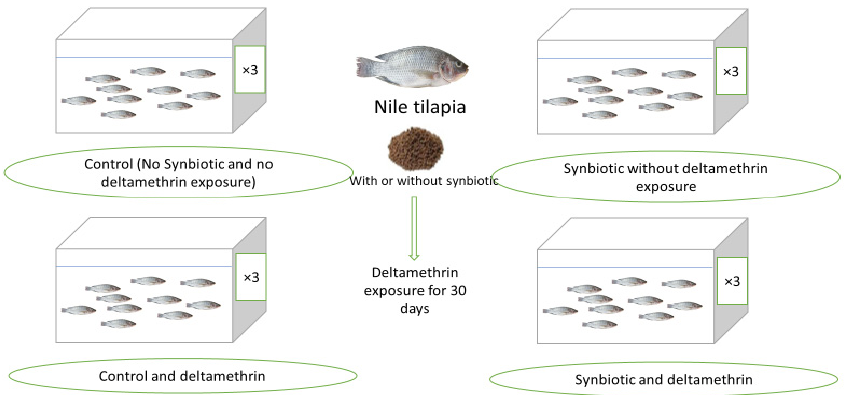
Figure 1. Schematic summary of the study protocol.